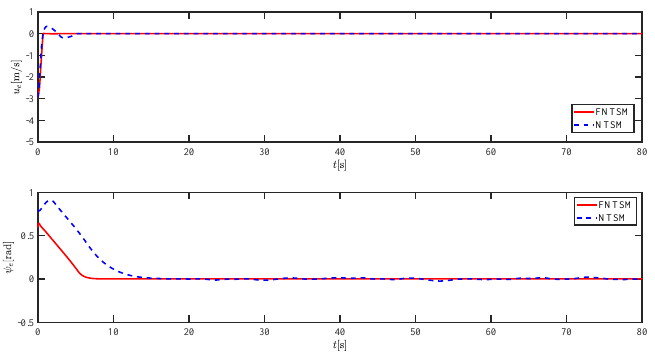
Figure 7. Comparison results of u e and ψ e at moderate speed.